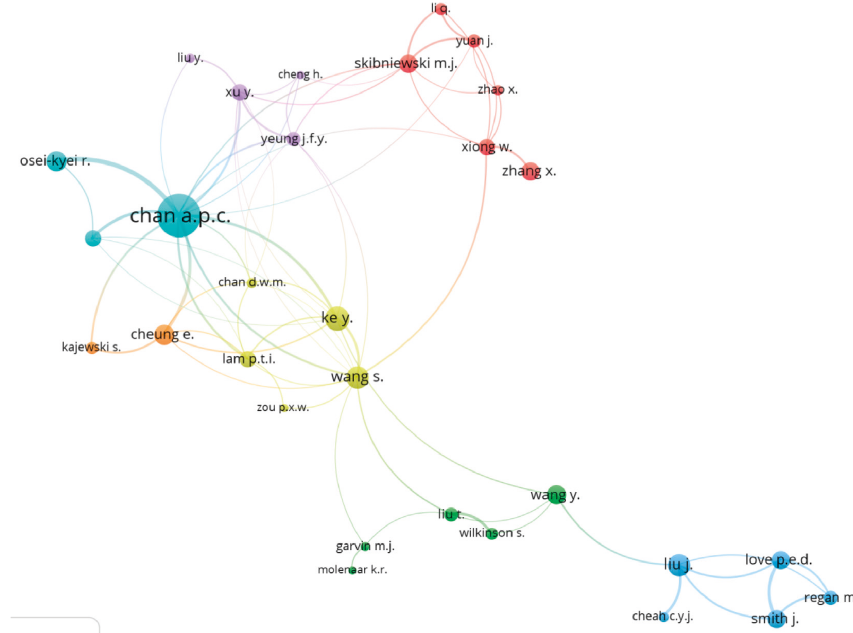
Figure 5: Coauthorship